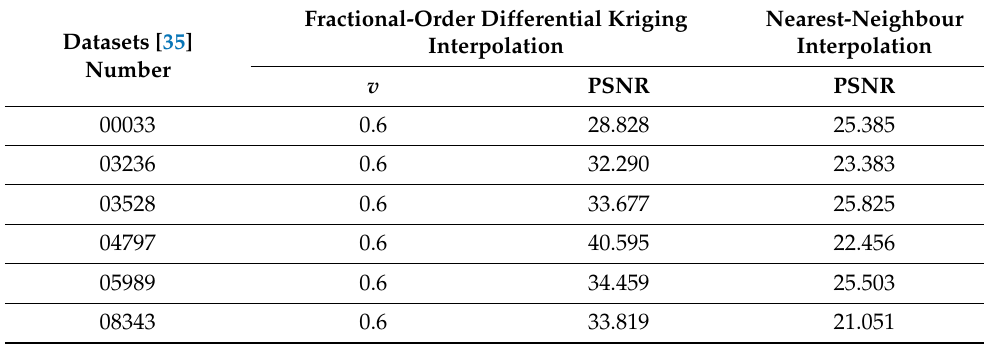
Table 3. Super-resolution results of the method based on fractional-order differential Kriging interpo- lation (400% up-sampling) and the nearest-neighbour interpolation method.